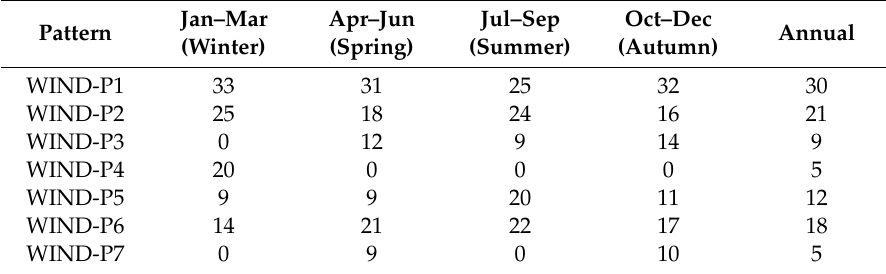
Table 2. Seasonal and annual frequencies of the wind circulation patterns